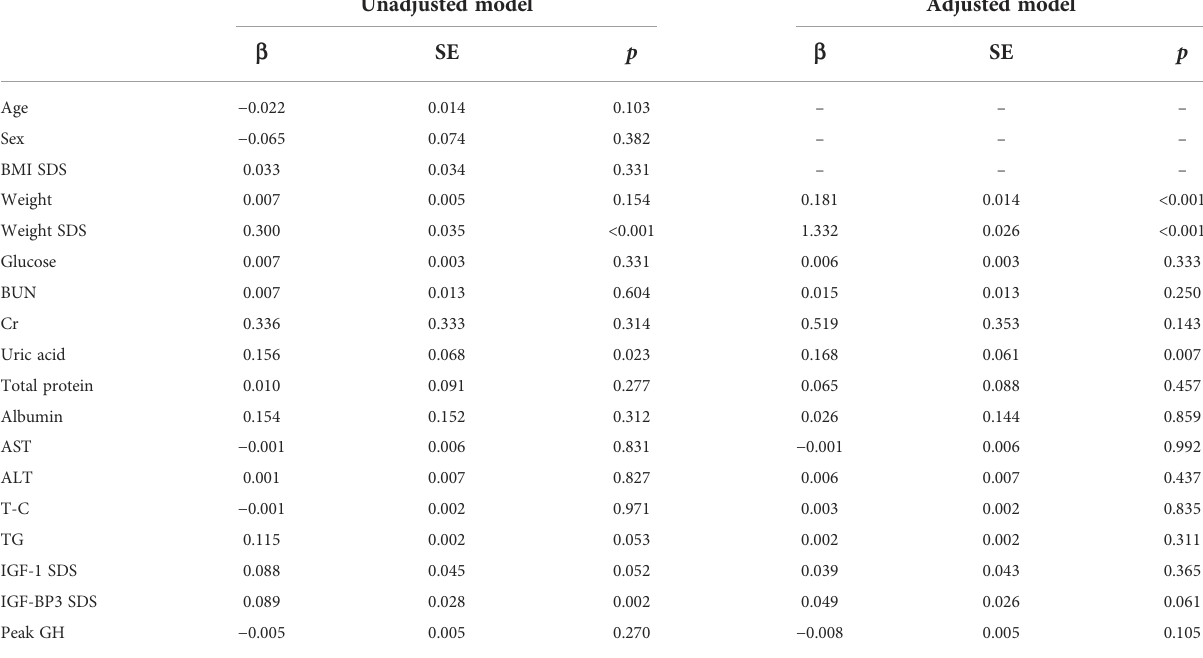
TABLE 3 Association of height SDS with anthropometric and biochemical variables using unadjusted and adjusted multiple linear regression analyses at baseline.